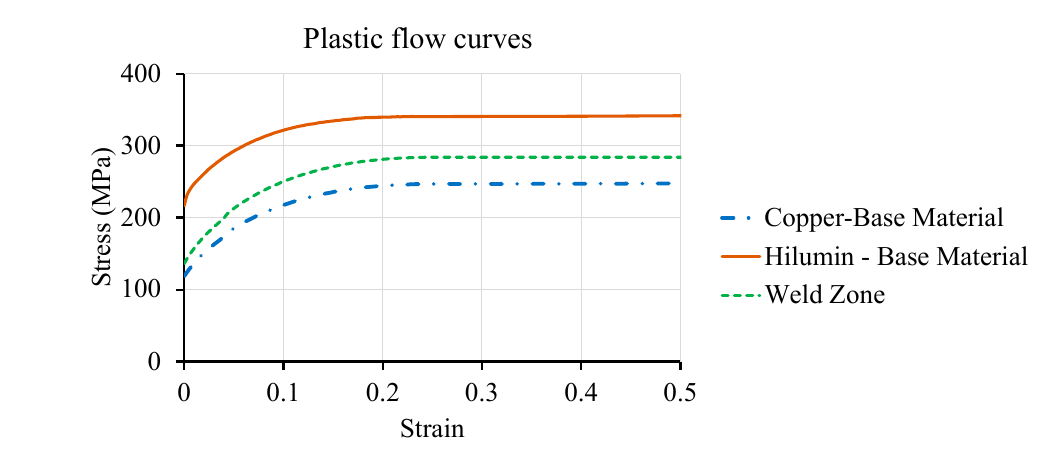
Figure 7. Plastic flow curves of base materials (i.e., copper, Hilumin steel) and weld zone. Table 5. Additional material data and model specific details used to develop the FE model.